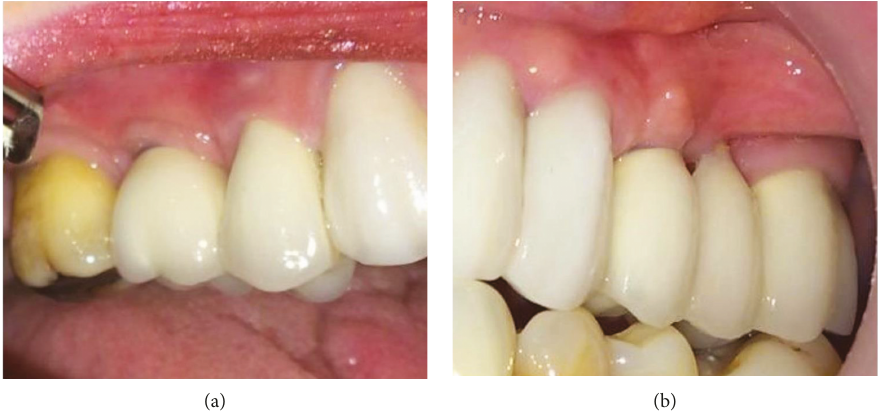
Figure 4: Prosthetic crowns 2 years after the cementation. (a) Right side of the maxilla. (b) Left side of the maxilla.